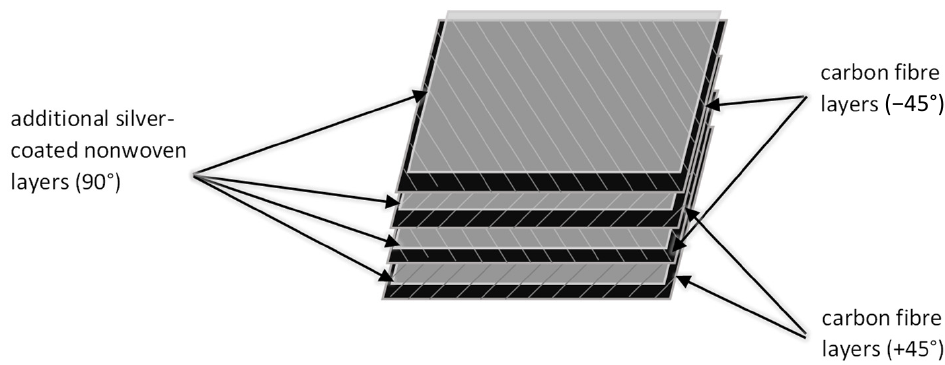
Figure 2. Schematic of layering in the composite with fiber orientation (source: own work on the basis of